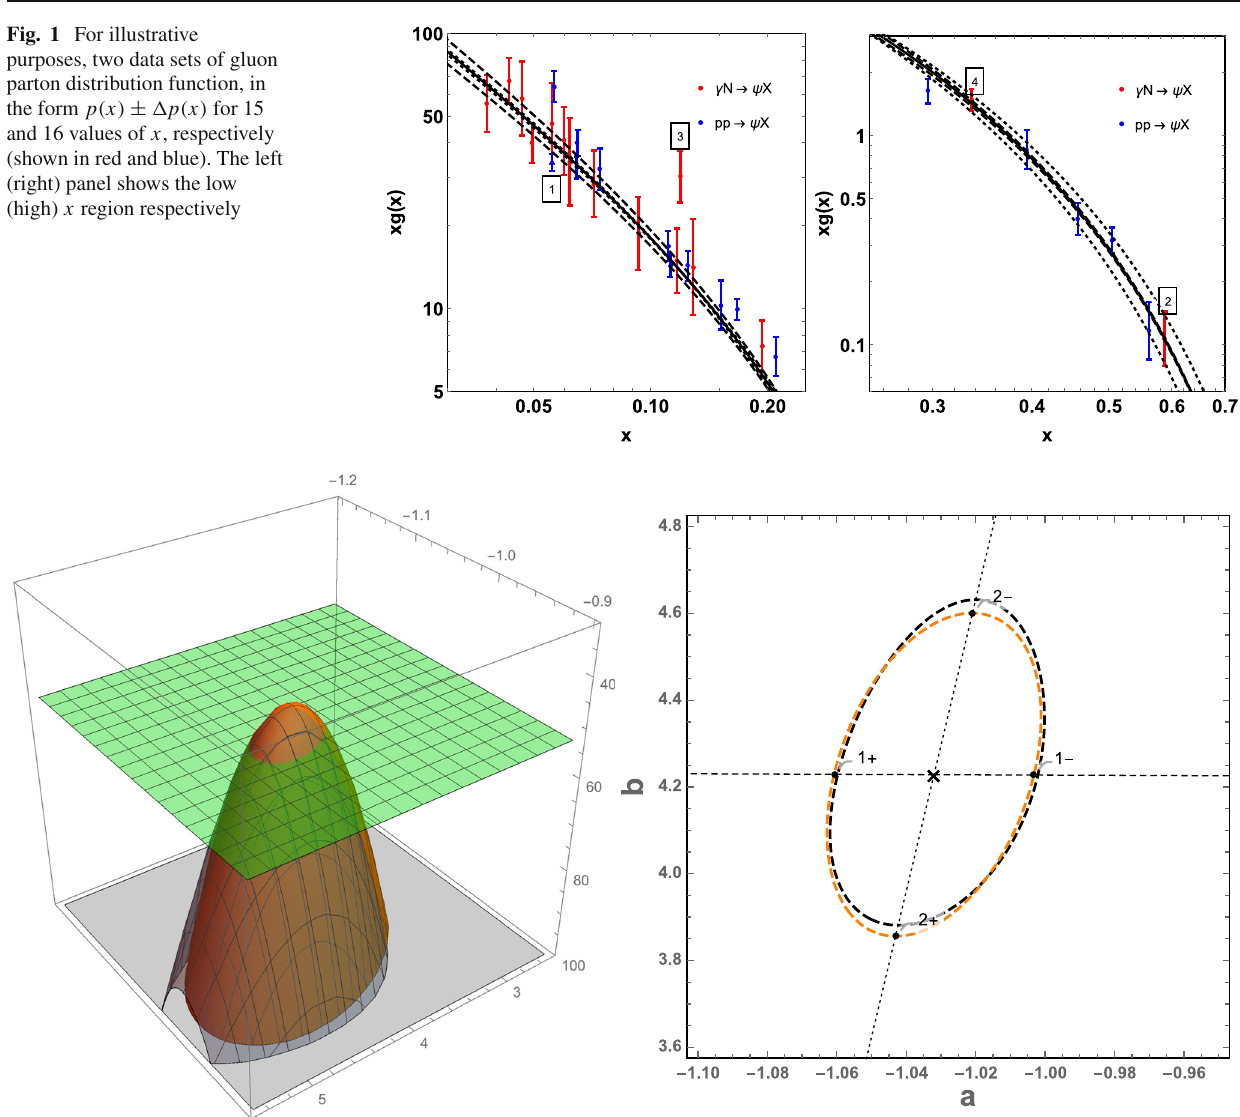
Fig. 2 Difference between the χ 2 -function (black), and quadratic approximation (orange). Their intersection with a 95% confidence level plane is shown on the right panel. The intersections of the principal axes